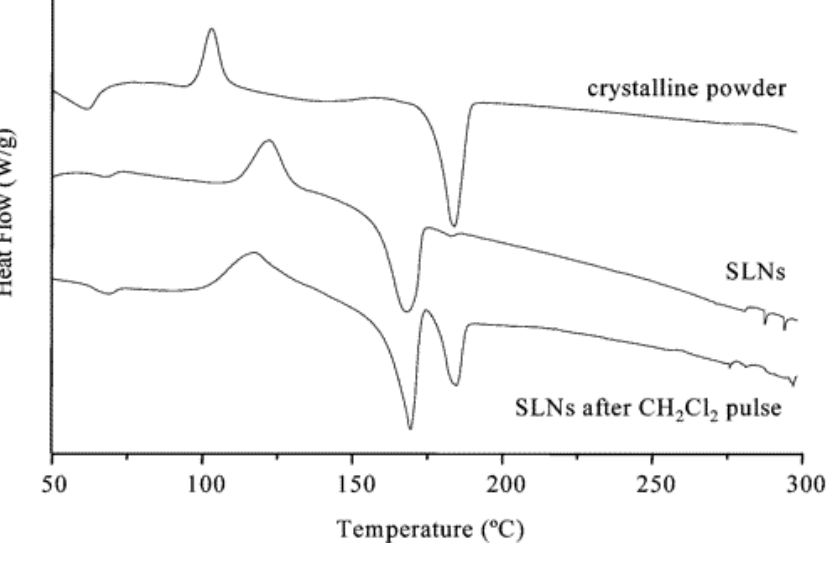
Figure 9. Differential scanning calorimetry traces for para -hexanoyl calix-[4]arene 2a